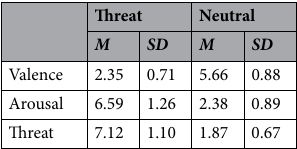
Table 2. Mean ratings of valence, arousal, and threat degree for each picture type and the SD